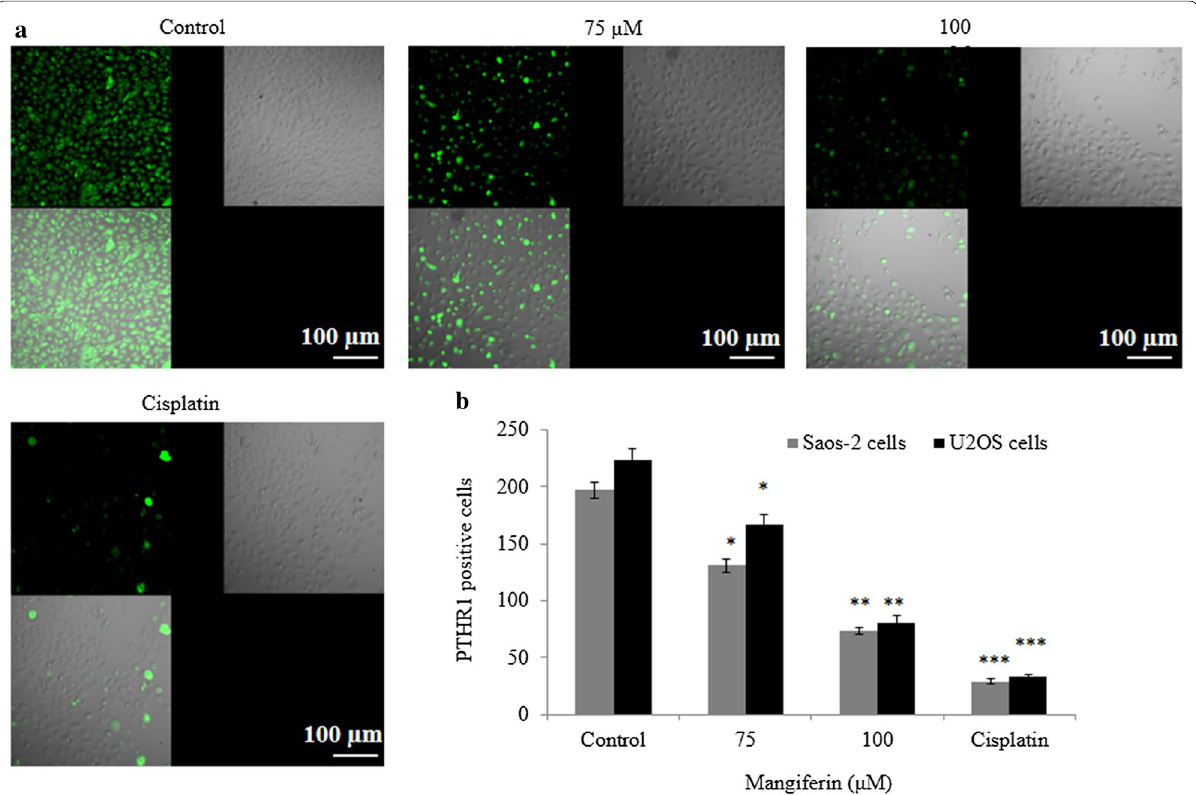
Fig. 8 Protein expression of PTHR1, as determined by immunohistochemistry in osteosarcoma cells following mangiferin treatment. Cells were treated with mangiferin (75 and 100 µM) for 72 h. a Immunohistochemical confocal images in Saos-2 cells and b PTHR1-positive cells. N vs. * P < 0.05. Scale bar is 100